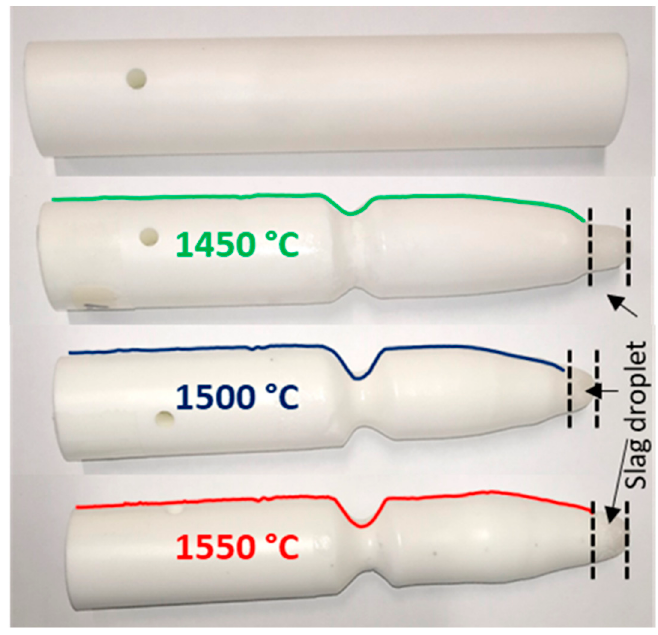
Figure 3. Virgin and corroded samples with MCPs of the last steps of magnesia dissolution super- imposed.